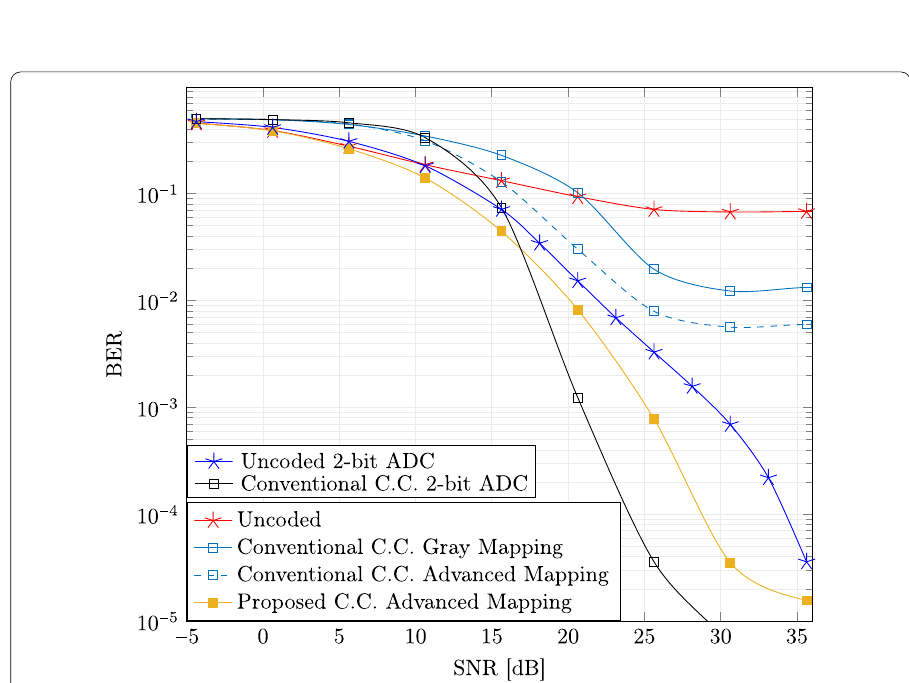
Fig. 13 BER results for a code rate of 7/9, M cpm = 8 , M = 3 for the 1-bit ADC and M = 1 for a 2-bit